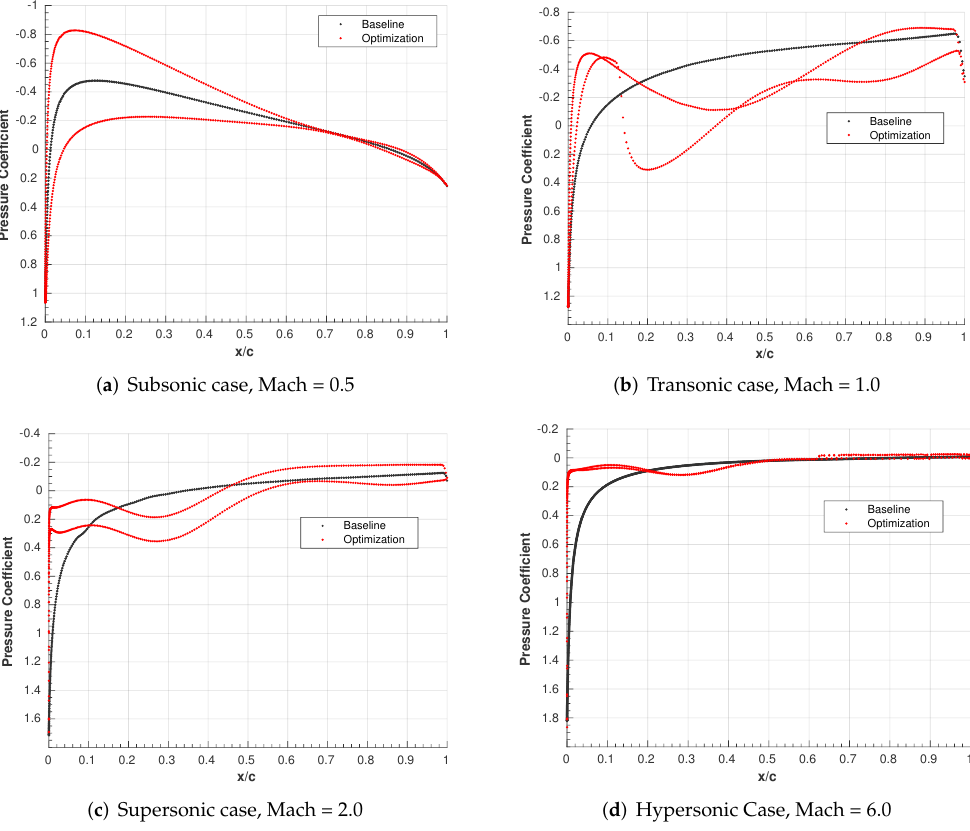
Figure 11. Comparison between baseline and optimized pressure coefficient distributions. ( a ) Subsonic case, Mach = 0.5. ( b ) Transonic case, Mach = 1.0. ( c ) Supersonic case, Mach = 2.0. ( d ) Hypersonic case, Mach =